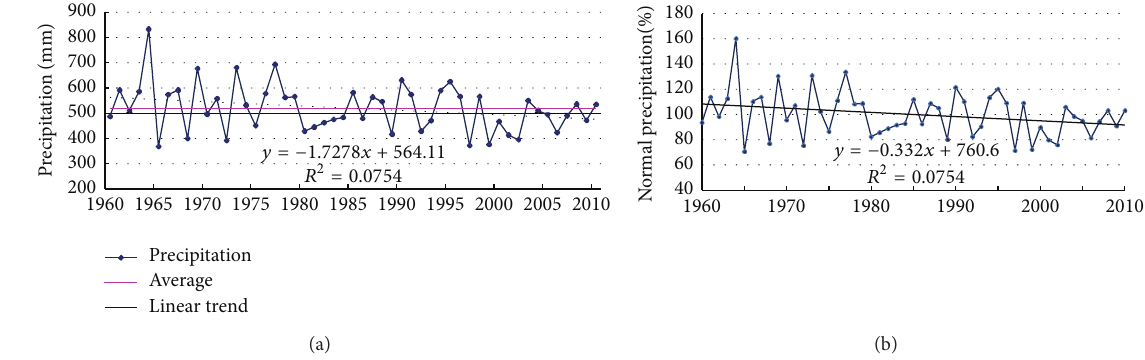
Figure 2: (a) Time series of total annual precipitation averaged over whole Beijing-Tianjin-Hebei metropolitan areas and (b) percent of normal precipitation index computed with respect to 1961–1990 climate normal.